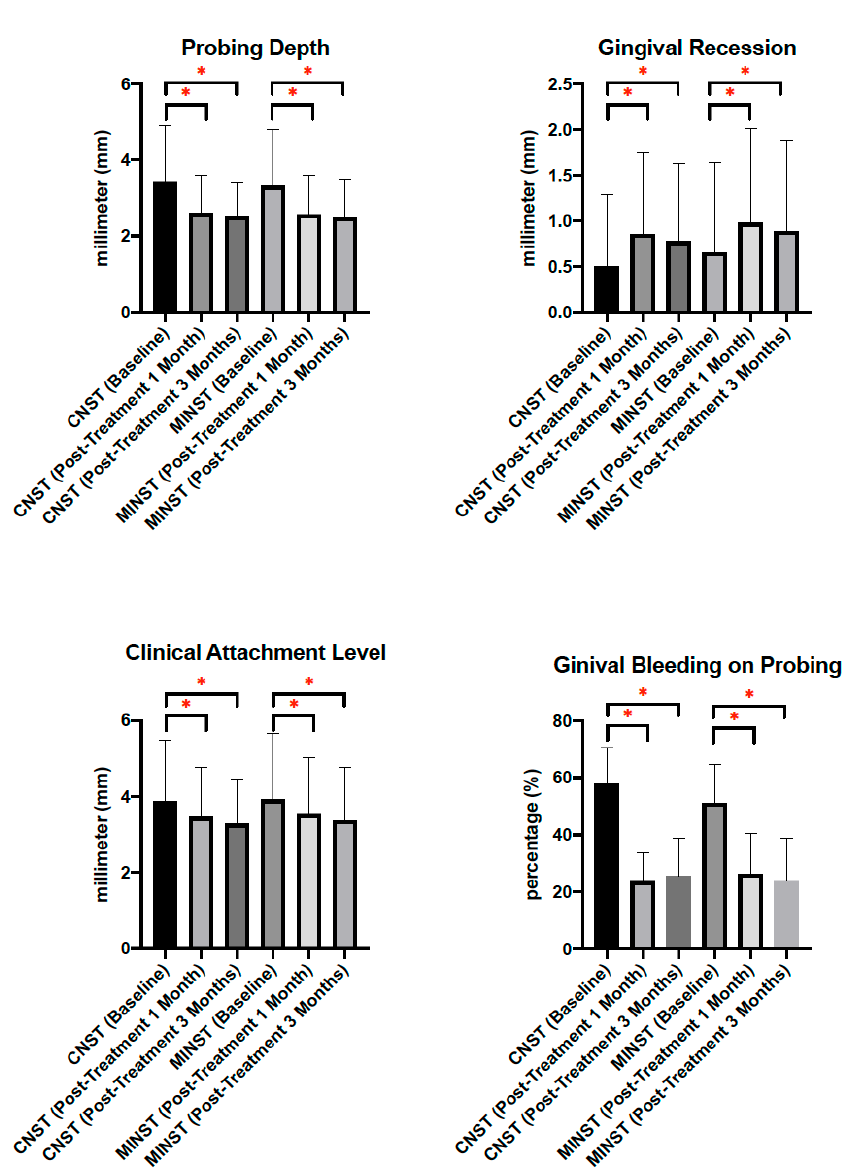
Figure 2. Periodontal parameters. Mann–Whitney U test was used for inter-group comparison, and Wilcoxon signed-rank test was used for intra-group comparison. *: p value < 0.05.